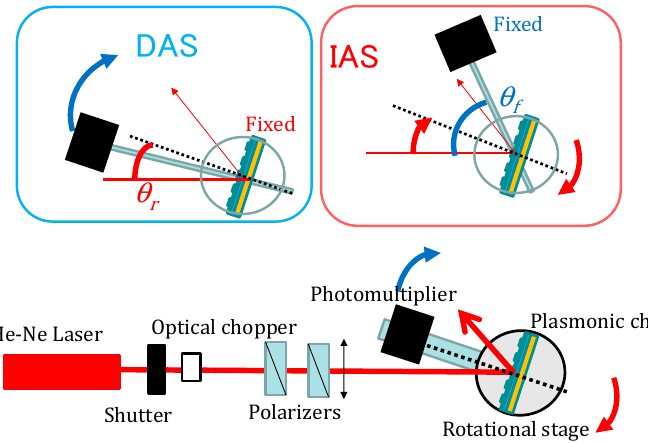
Figure 8. Surface plasmon field-enhanced fluorescence (SPF) setup and optical configuration for DAS and IAS measurement system.